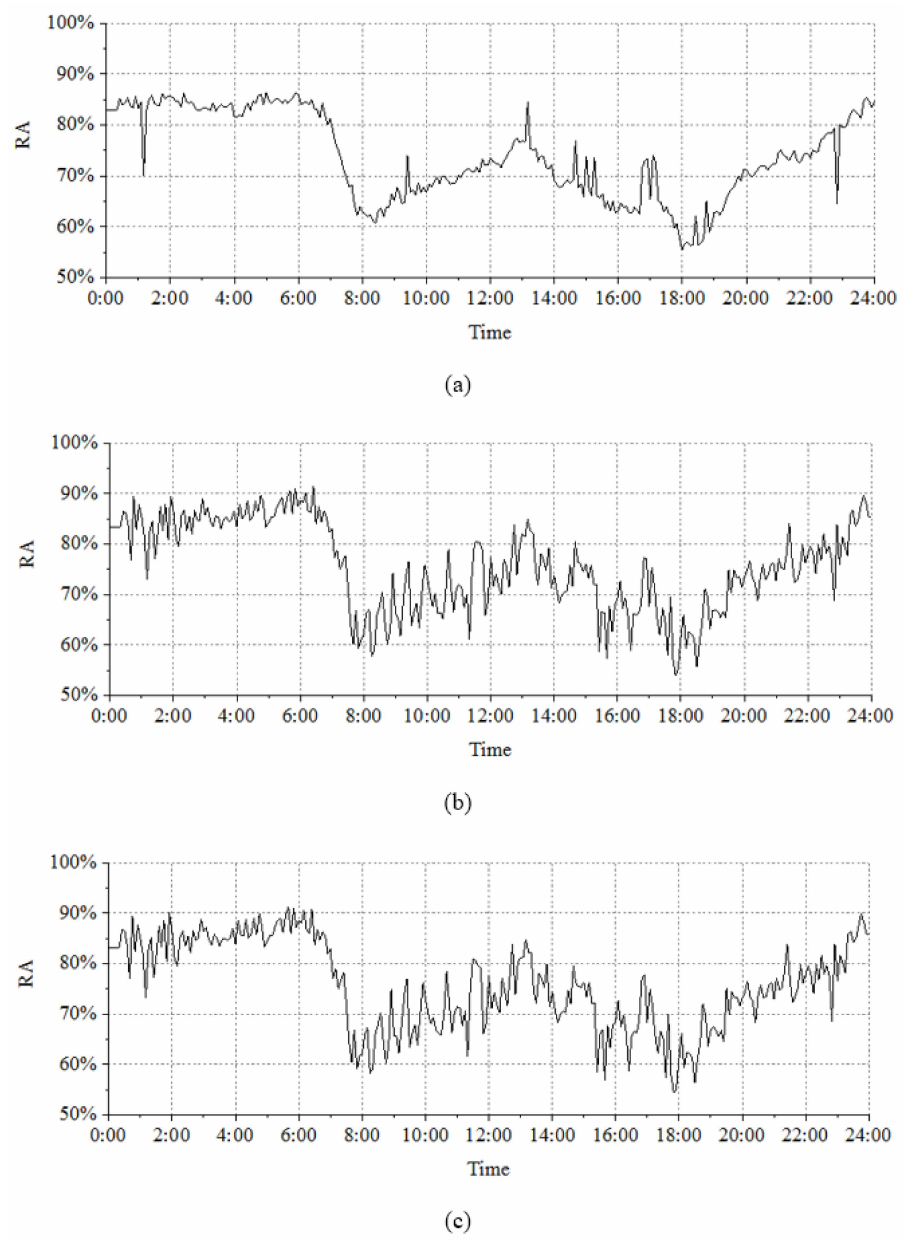
Figure 4. Traffic conditions of Shenzhen on 19 October 2015 (Monday) characterized with different measuring scales: ( a ) 10 km/h; ( b ) 1 km/h; and ( c ) 0.1